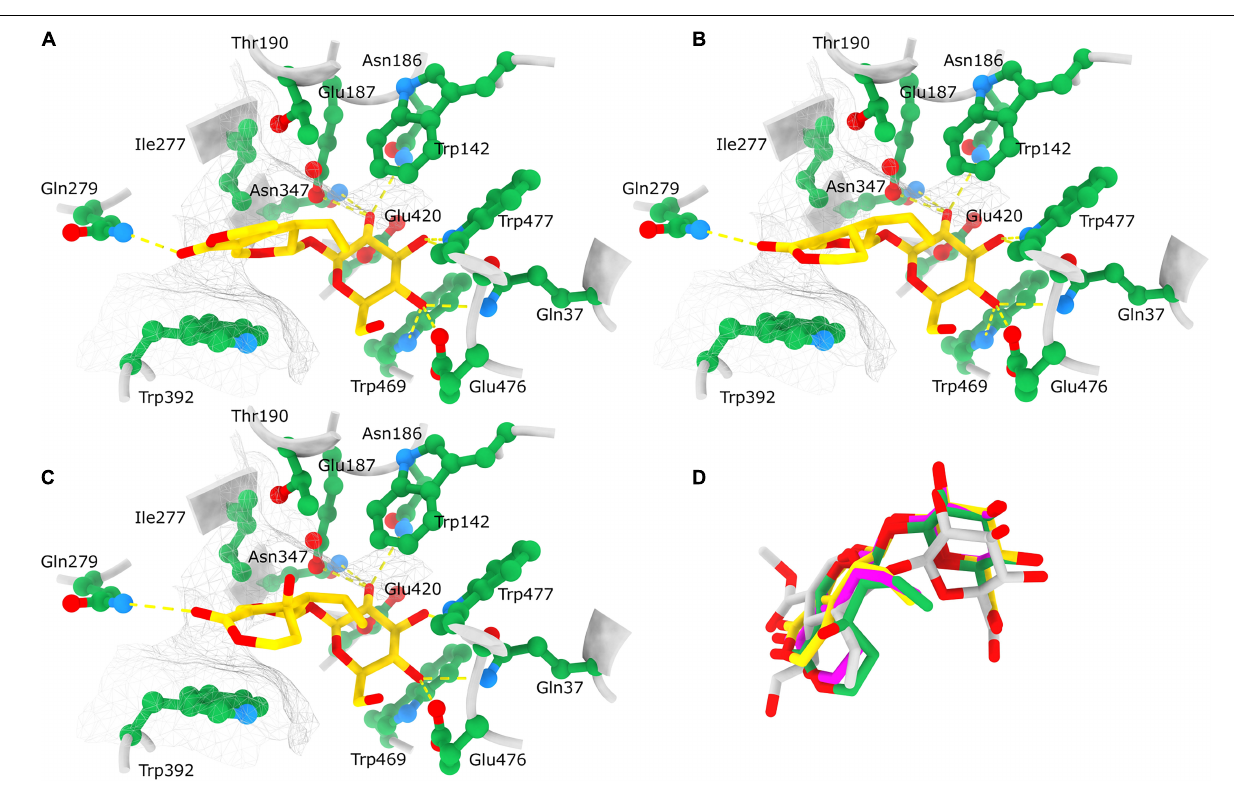
FIGURE 10 | Position of docked ligands in the Ce BGlu1 active site. Interactions of docked ligands: gentiopicrin (A) , sweroside (B) and swertiamarin (C) with the Ce BGlu1 active site residues. Ligands are colored yellow with oxygen shown in red; active site residues are colored green with oxygen shown in red and nitrogen in blue. H-bonds are indicated with yellow dashed lines while the hydrophobic surface encompassing the aglycone is indicated with a silver mesh. (D) Superposition of ligands docked to the Ce BGlu1 active: gentiopicrin (yellow), sweroside (pink) and swertiamarin (green) with secologanin (gray) from the experimental structure of glucosidase from Rauvolfia serpentina (PDB: 3U5Y). Superposition of Ce BGlu1 with 3U5Y was performed using matchmaker command in ChimeraX using default